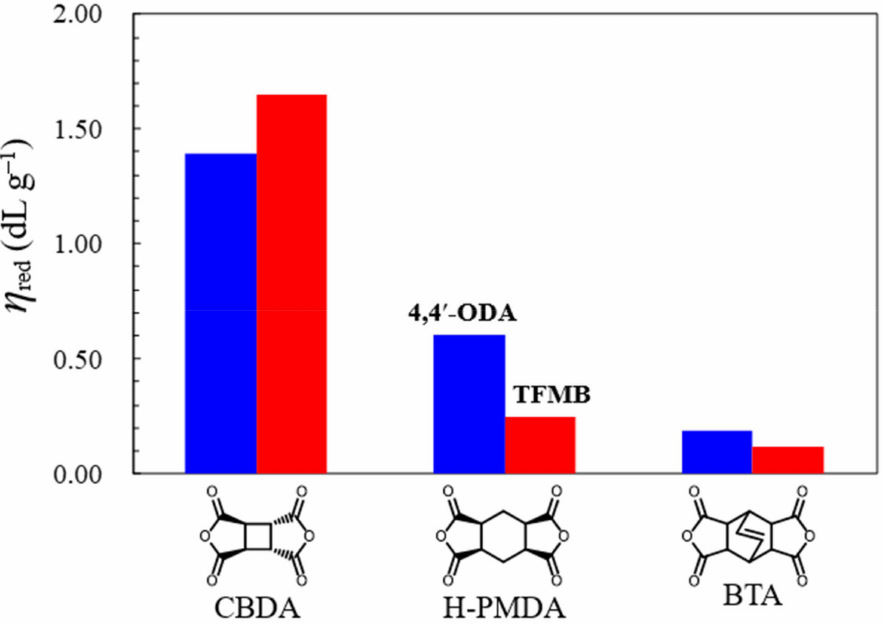
Figure 7. The η red (PAA)-based relative polymerizability of typical mass-produced cycloaliphatic tetracarboxylic dianhydrides (CBDA, H-PMDA, and BTA) with common aromatic diamines: ( left , blue bars) 4,4 (cid:48) -ODA; ( right , red bars) TFMB. Polyaddition was conducted in DMAc at an initial monomer content of 30